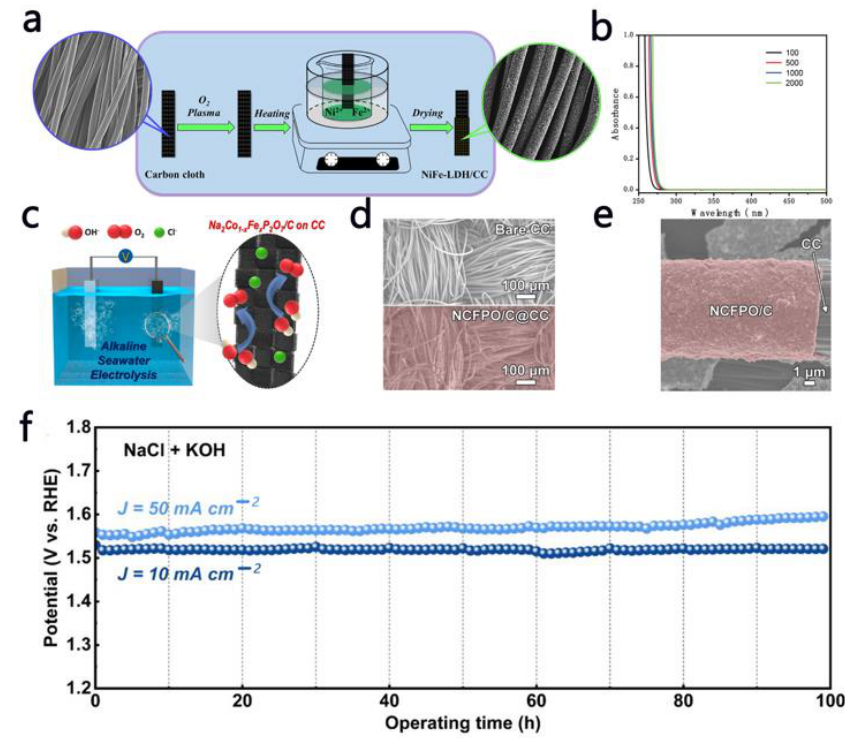
Figure 6. ( a ) Synthesis of NiFe LDH/CC. ( b ) UV-vis absorption spectra of electrolytes after the stability tests [62]. ( c ) Schematic diagram of OERs on an NCFPO/C@CC electrode [63]. FESEM images of ( d ) bare CC and ( e ) NCFPO/C@CC [63]. ( f ) Stability of NCFPO/C@CC [63]. Adapted with permission from Ref. [62], Copyright 2021, Elsevier Ltd.; Ref. [63], Copyright 2019, American Chemical Society.